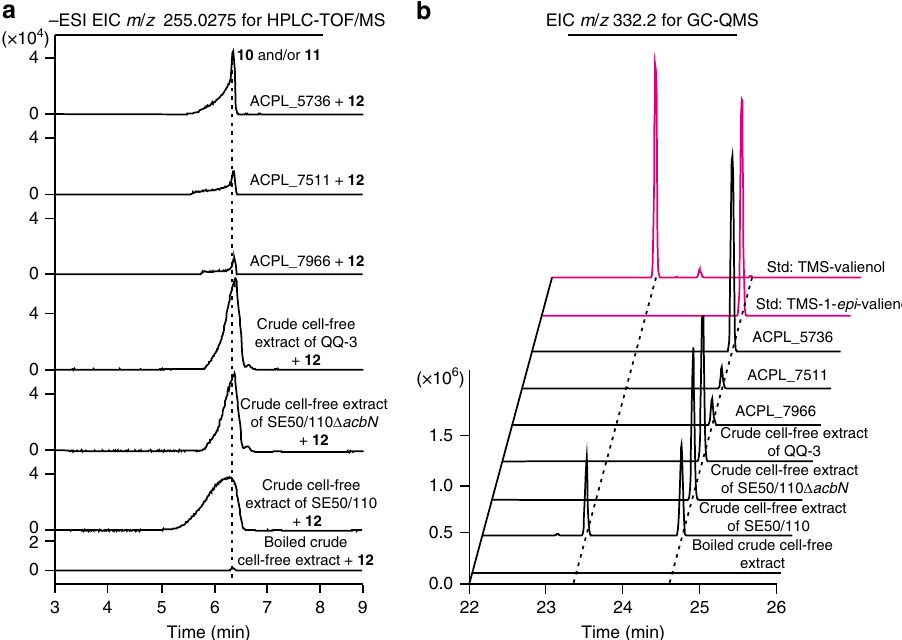
Fig. 5 Elucidation of the biosynthetic pathway to the shunt product 8. a HPLC-TOF/MS analysis of the reduction products of 12 by the crude cell-free extract of Actinoplanes sp. SE50/110 (abbreviated as SE50/110), SE50/110 Δ acbN and QQ-3, puri fi ed ACPL_7966, ACPL_7511 and ACPL_5736 proteins, and the reaction with boiled crude cell-free extract (BCF) was set as a negative control. All the chromatograms show the extraction of calculated ion m / z = 255.0275 [M-H] − . b GC-QMS con fi rmation of the con fi guration of the reaction products after dephosphorylation by AcbJ. AcbJ was added to the reaction products of crude cell-free extract of Actinoplanes sp. SE50/110, SE50/110 Δ acbN , and QQ-3, puri fi ed ACPL_7966, ACPL_7511, ACPL_5736 proteins, and control reaction. The standards (std) 8 and 9 were also analyzed by GC-QMS after derivatization by BSTFA. For more details, see also Supplementary Fig. 11. All the chromatograms show the extraction of unique product ion m / z = 332.2. TMS is the abbreviation of trimethyl silicyl. Source data are provided as a Source Data fi